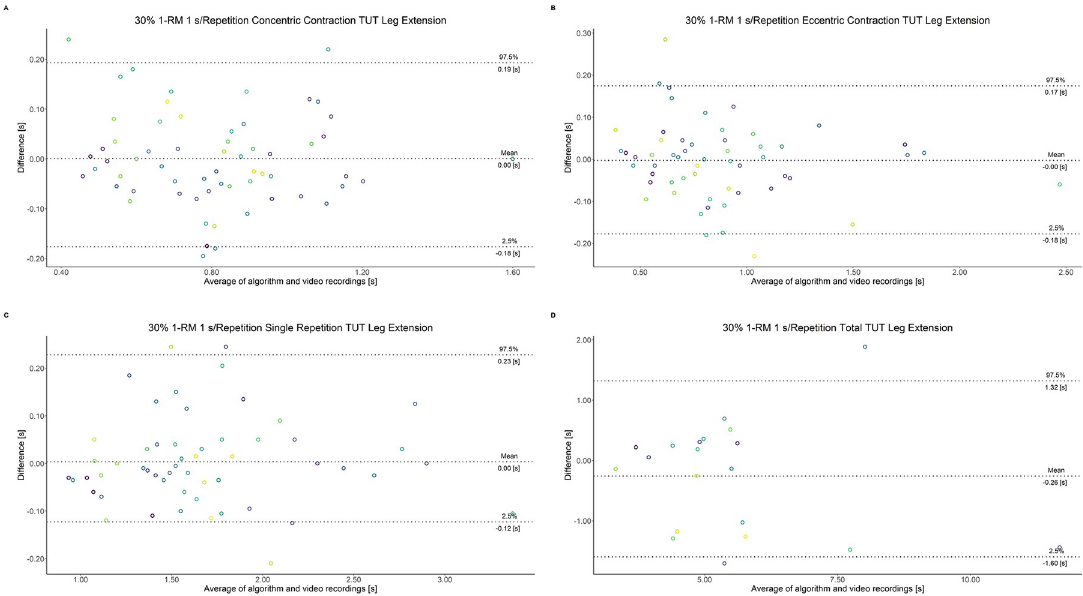
Fig 3. Bland-Altman plots of agreement between algorithmically accelerometer derived and video recordings derived contraction- specific phases of the leg extension machine at 30% 1-RM with a velocity of 1 s per repetition. A: Concentric contraction phase. B: Eccentric contraction phase. C: Single repetition. D: Total time-under-tension.